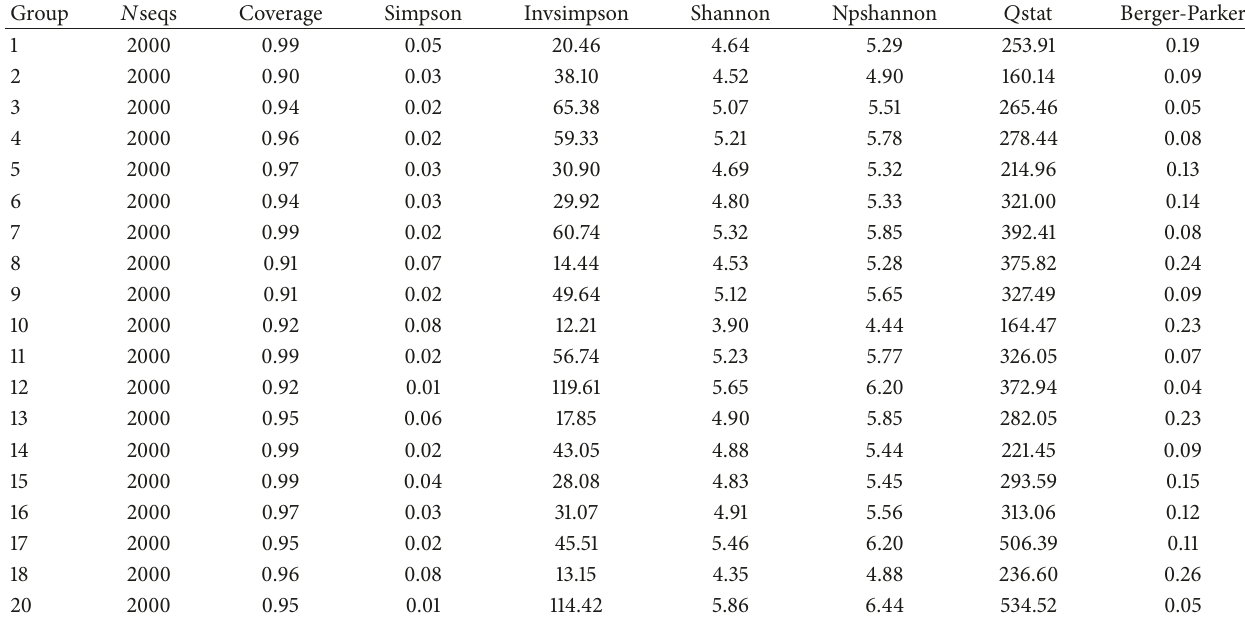
Table 3: Community diversity indices: Coverage, Simpson, Invsimpson, Shannon, Npshannon, 𝑄 stat, and Berger-Parker. Group 𝑁